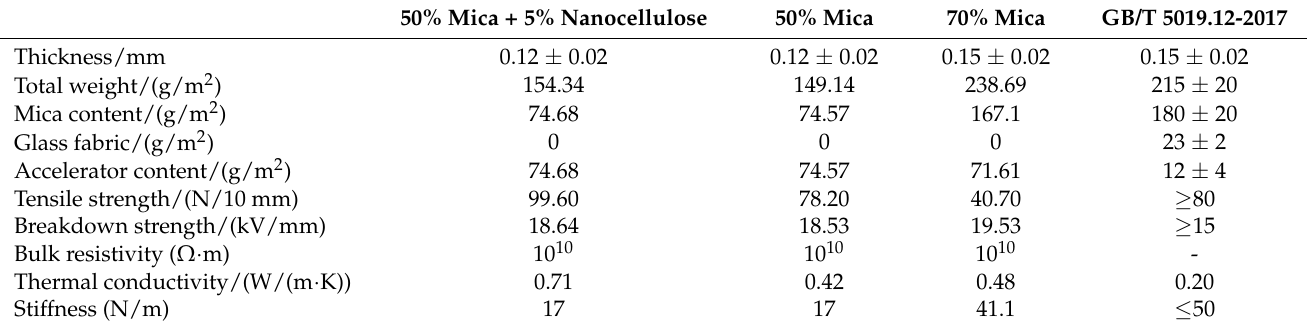
Table 1. The performance table of the mica/chitosan and mica/chitosan/nanocellulose composites.